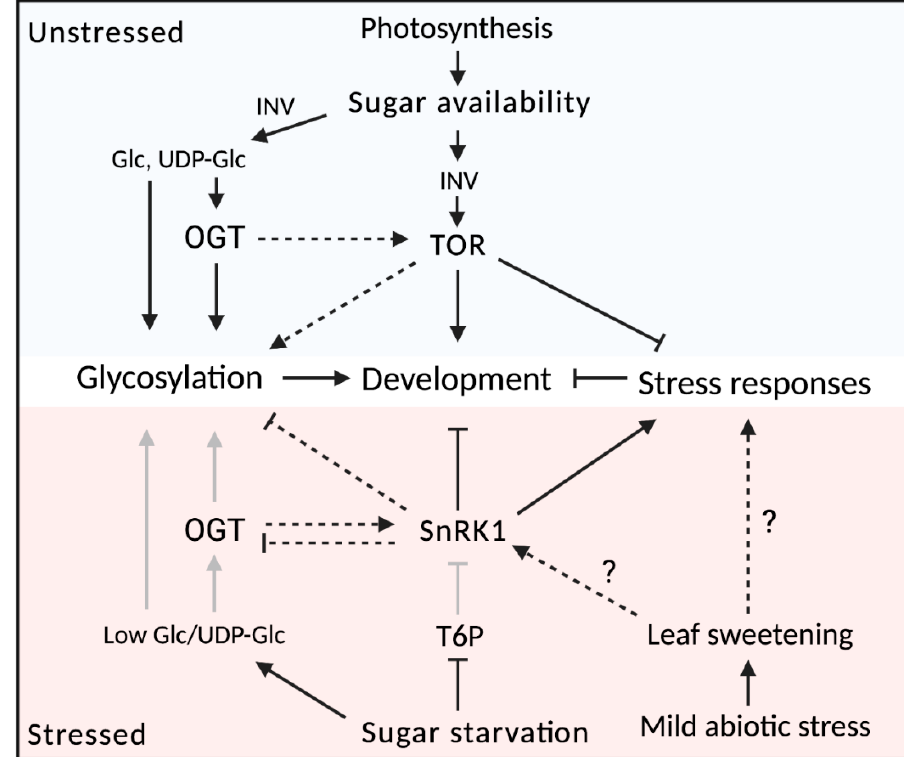
Figure 6. Scheme illustrating the links between sugar metabolism/signaling and glycosylation and the trade-off between growth and stress responses. The figure illustrates the effect of sugar metabolism and signaling during unstressed conditions and stressed conditions in terms of sugar availability. Under non-stressed conditions, photosynthesis provides sugars to be used in metabolism and directly in glycosylation reactions. Sugar availability stimulates Target of Rapamycin (TOR), promoting growth and development and inhibiting stress responses. Sugar availability can also directly influence glycosylation by serving as the substrates, for instance through O-GlcNAc trans- ferases (OGTs). Invertases (INVs) are key components, specifically in sink tissue, to convert sucrose to metabolizable hexoses. Under these conditions, Snf1-related protein kinase 1 (SnRK1) is inhibited by trehalose-6-phosphate (T6P). When exposed to severe stresses, photosynthesis is hampered, resulting in sugar deprivation, reflected through T6P levels (mirror sucrose levels). Low T6P results in an active SnRK1, inhibiting growth and possibly also glycosylation by regulating OGTs as is the case in animals. Active SnRK1 also promotes stress responses. It is important to note that mild abiotic stresses result in temporal leaf sweetening which can also potentially stimulate SnRK1 and/or stress responses. During sugar deprivation, TOR is typically inactive. Apart from sugar signaling pathways, limited sugar availability can also directly hamper glycosylation due to limited substrate availability and low energy levels. It is unclear whether a sugar sensor exists that translates sugar availability to glycosylation reactions in plants; however, candidates include OGTs themselves or SnRK1, since this appears to be the case in animals. In animals, AMP-activate protein kinase (AMPK), the homolog of SnRK1, and OGTs co-regulate one another to alter their activities and localization. It is important to note that glycosylation will never be completely inhibited even under severe stresses, as a low level of glycosylation is also important during these conditions. Arrows with arrow heads indicate stimulatory effects whereas arrows with blunt ends indicate inhibitory effects. Solid lines are known effects and dashed lines predicted effects. Grey arrows indicate an inactive pathway under a specific condition. This figure was created with